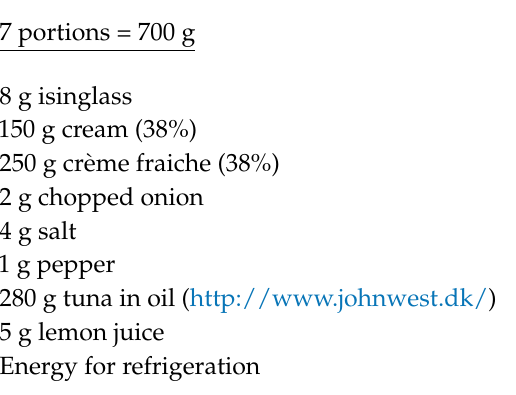
Procedure: Pour the tuna onto a sieve to relieve it of water. Blend the tuna, onion, sour cream, and lemon juice. Hydrate four leaves of isinglass in cold water, wring it for water, mix it with a couple of spoonful’s boiling water, and pour it slowly into the mixture while stirring. Whip the cream and facilitate drawing patterns in the surface. Place in a refrigerator for a minimum of 3